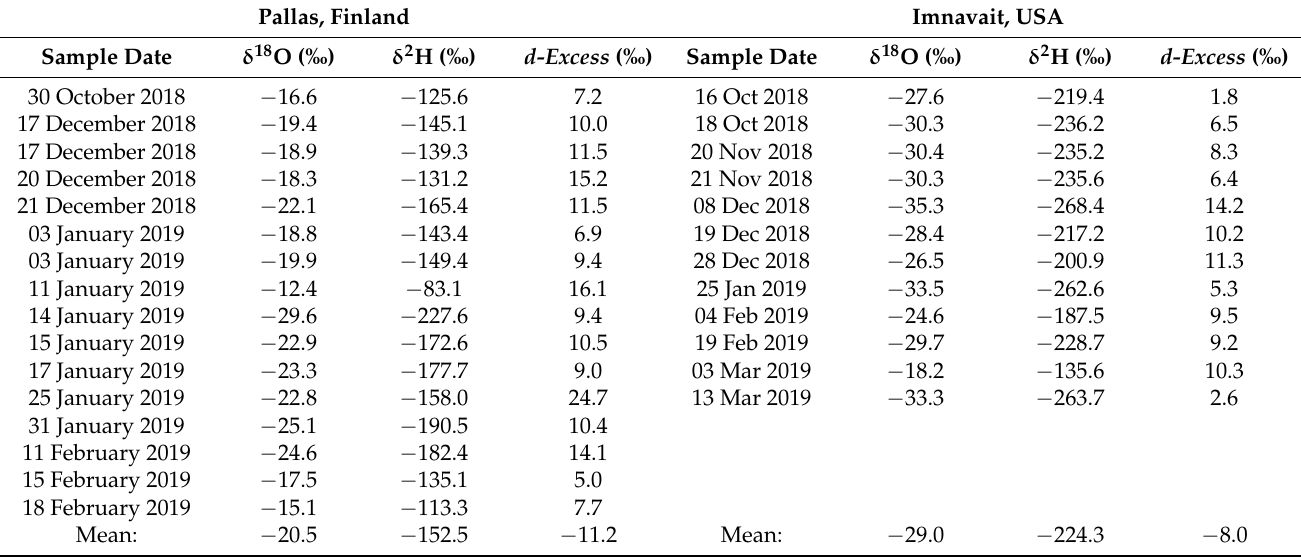
Table A1. Winter 2018–2019 Imnavait and Pallas snowfall samples and stable isotope